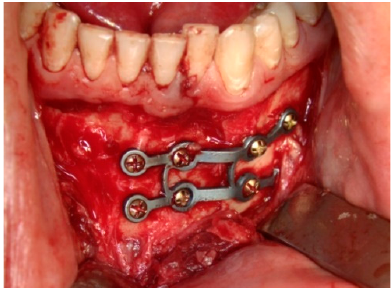
Figure 1. Internal fixation of the anterior fracture using the plate M-4484 (Medartis Trauma 2.0).